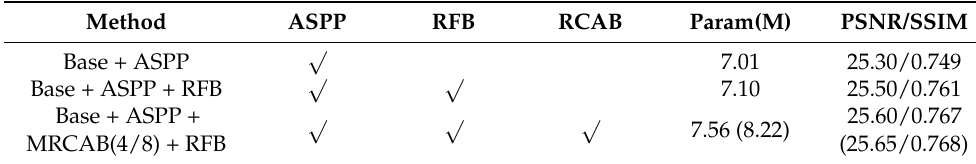
Table 3. Ablation study on the transformer Table 2. Ablation study on reference images with different levels of similarity.